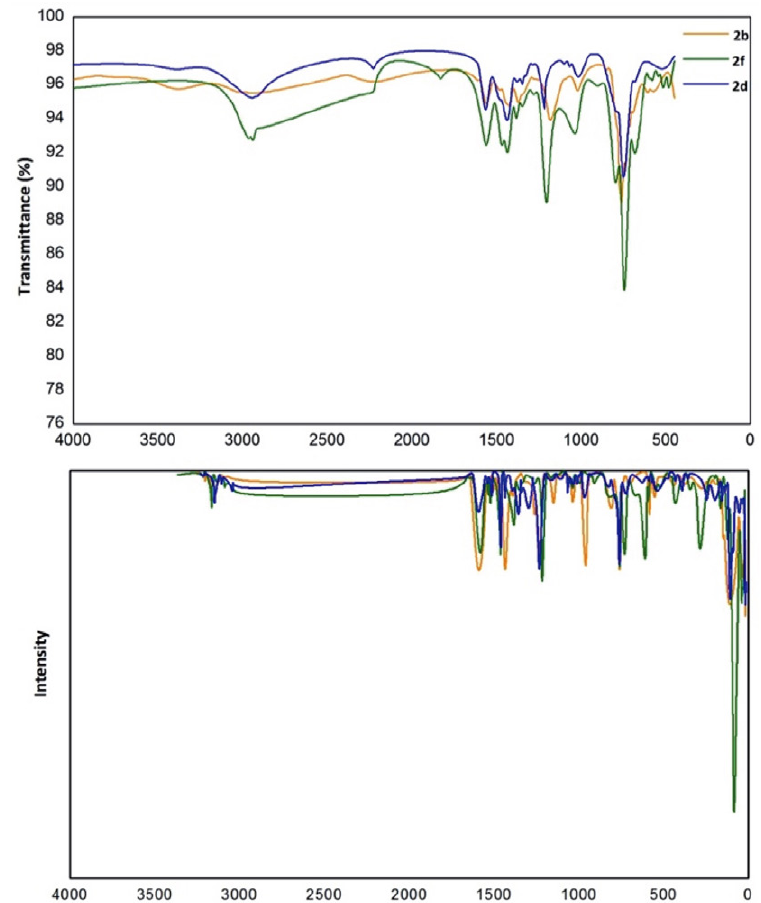
Fig. 6. The experimental (above) and calculated (below) IR spectra of the meta -cyanobenzyl substituted benzimidazolium